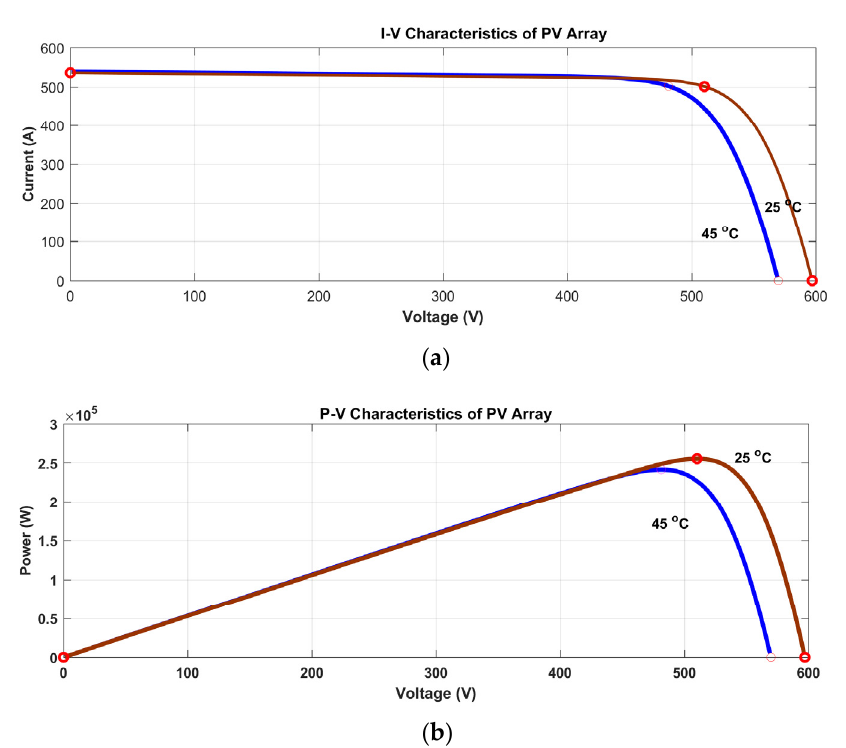
Figure 15. Characteristics of PV array: ( a ) current versus voltage and ( b ) power versus voltage for different temperatures of 25 ℃ and 45 ℃ .